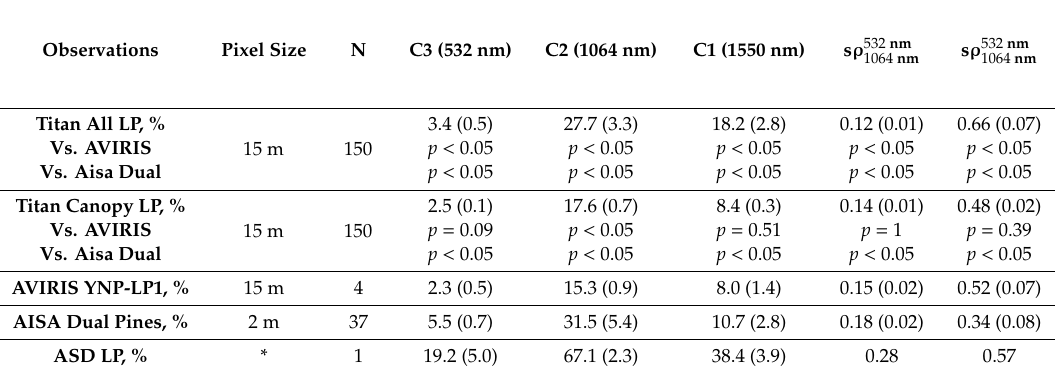
Table 5. Comparison of spectral pseudo-reflectance derived from Titan single returns (SD in brackets) for LP stand in Cypress Hills to spectral reflectance data derived from di ff erent locations from AVIRIS, AISA Dual, and ASD, and calculated two simple ratios ( s ρ 532nm Mann-Whitney test comparing Titan’s spectral pseudo-reflectance and spectral ratios vs. AVIRIS and AISA Dual data are presented.